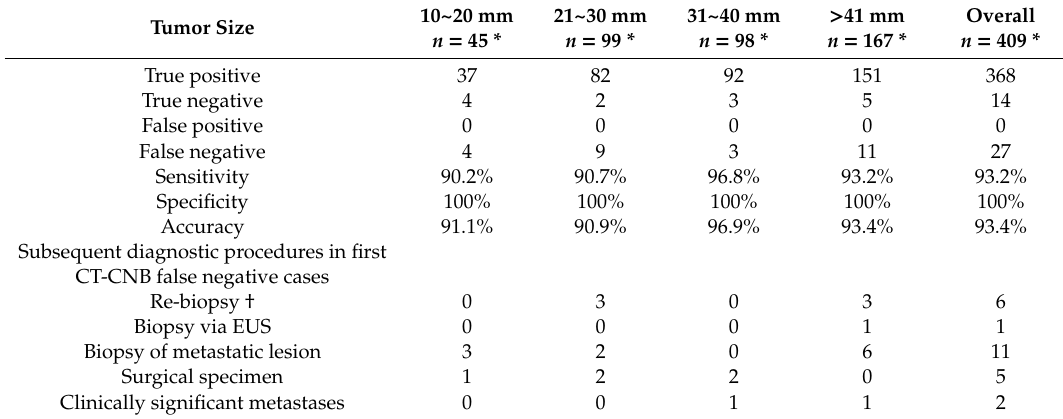
Table 3. Diagnostic performance of CT-CNB by tumor size in 409 cases with conclusive diagnosis.